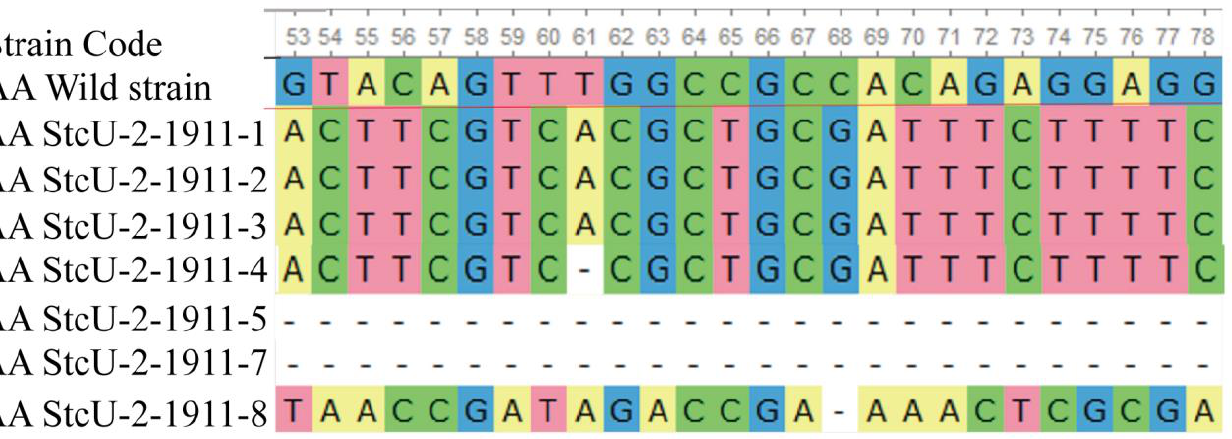
Figure 5. Clustal W sequence alignment of StcU-2 gene-edited mutants. AA Wild-Strain denotes Ascosphaera apis ( A. apis ) wild-strain protospacer sequence and PAM sequence.